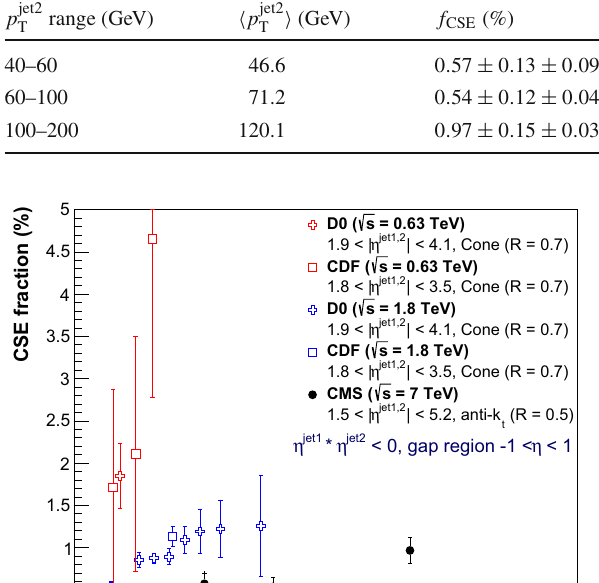
p jet2 range (GeV) T